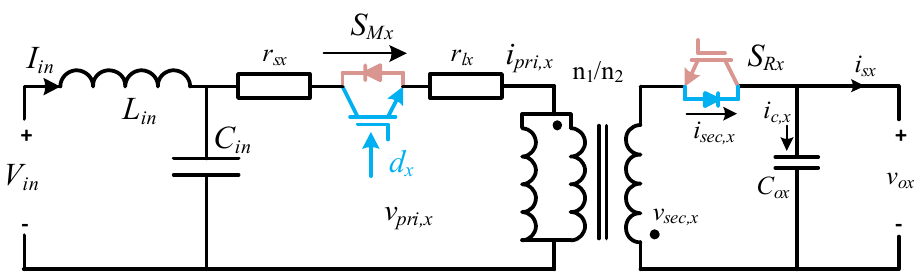
Figure 4. Single module bi-directional power flow of the proposed MFBDI.